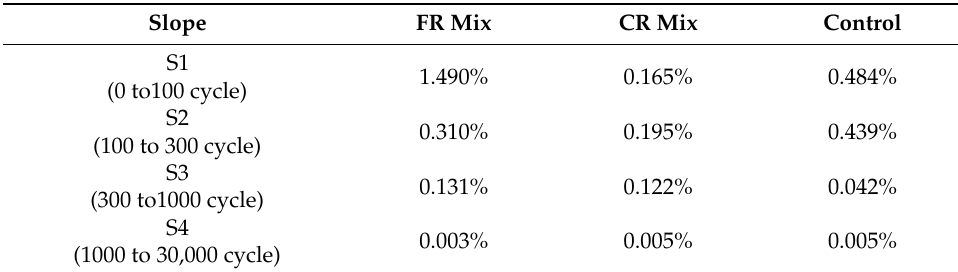
Table 3. Slope for each